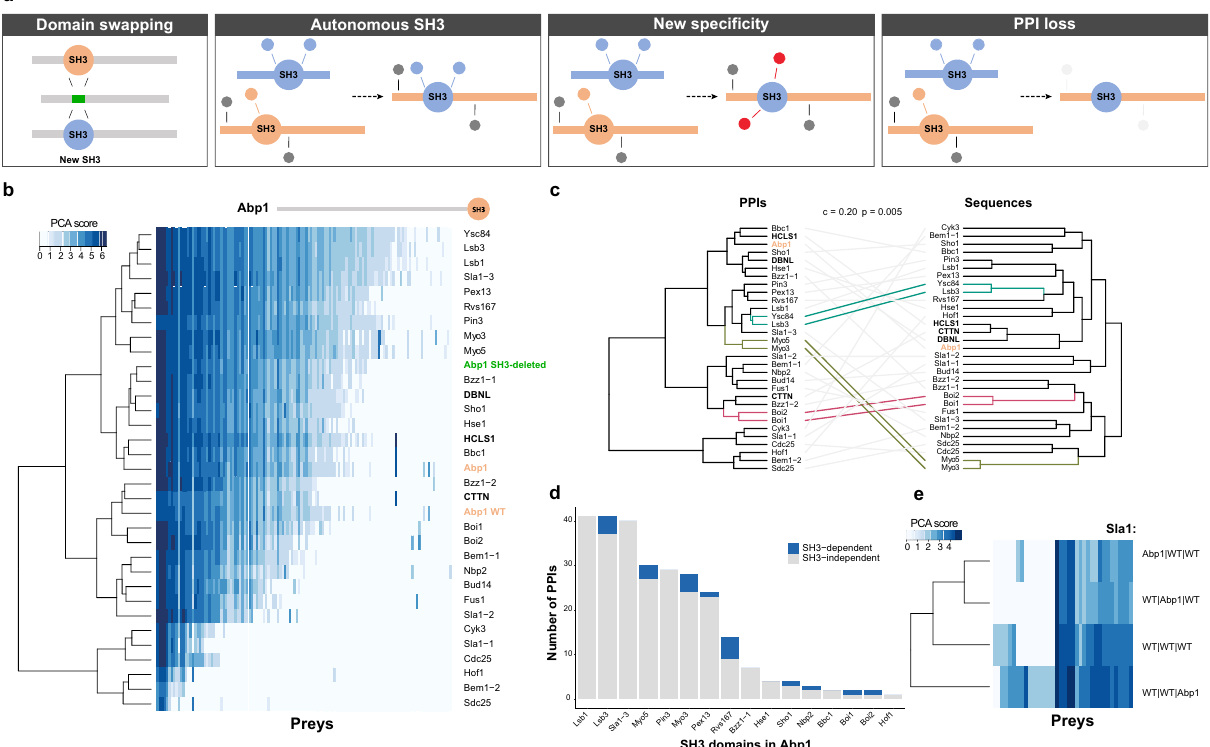
Fig. 2 SH3 domains are rarely suf fi cient to establish their endogenous speci fi city in their host protein. a In vivo SH3 domain swapping. The stuffer DNA from an SH3-deleted strain is replaced by SH3s from other genes. The consequences of SH3 swapping on the host protein PPIs are illustrated. b PPIs of Abp1 with its endogenous SH3 domain or with an SH3 from other yeast proteins or from its human orthologs. Blue shades correspond to PPI interaction scores measured by DHFR-PCA (PCA score). A scaled cartoon representation of Abp1 is shown above the heatmap. Bold SH3 domains represent human orthologous, orange SH3s are controls, and green is for the SH3-deleted protein. Each PPI was assessed in quadruplicate. c Cophenetic correlation between Abp1 SH3 swapped interaction clusters (based on the results of the panel b , n = 4 independent DHFR-PCA colony growth per Bait – Prey pairs) with the SH3 domain sequence similarity clusters. The empirical p value ( p = 0.005) was obtained from permutation. d Number of PPIs gained by Abp1 upon domain swapping. PPIs originally detected as dependent on the domain when present in its host protein are shown in blue (analysis performed with n = 4 independent DHFR-PCA colony growth per Bait – Prey pairs). e Sla1 PPIs with the SH3 from Abp1 inserted at each of the three SH3 positions. Each SH3